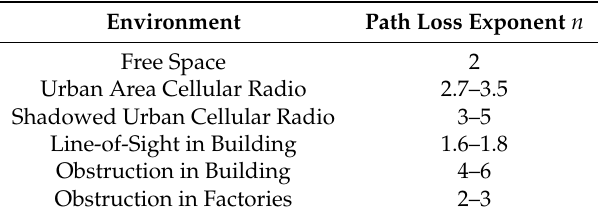
Table 4. Path loss exponents for different